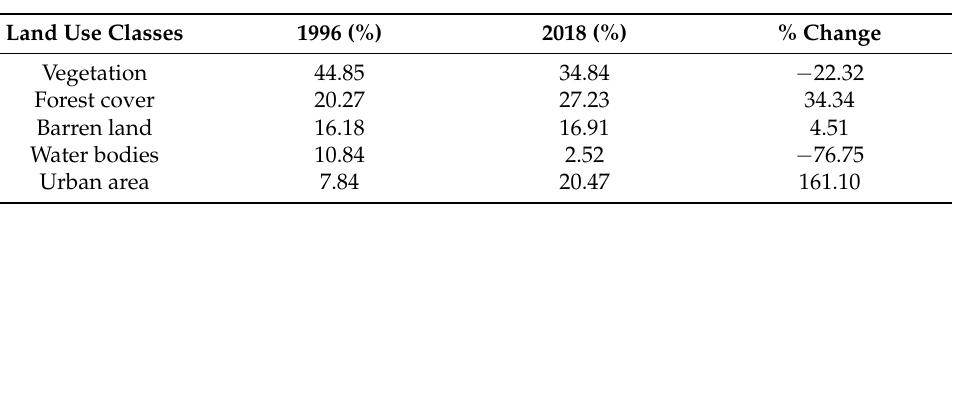
Table 3. Temporal changes in land use classes between 1996 and 2018 (expressed